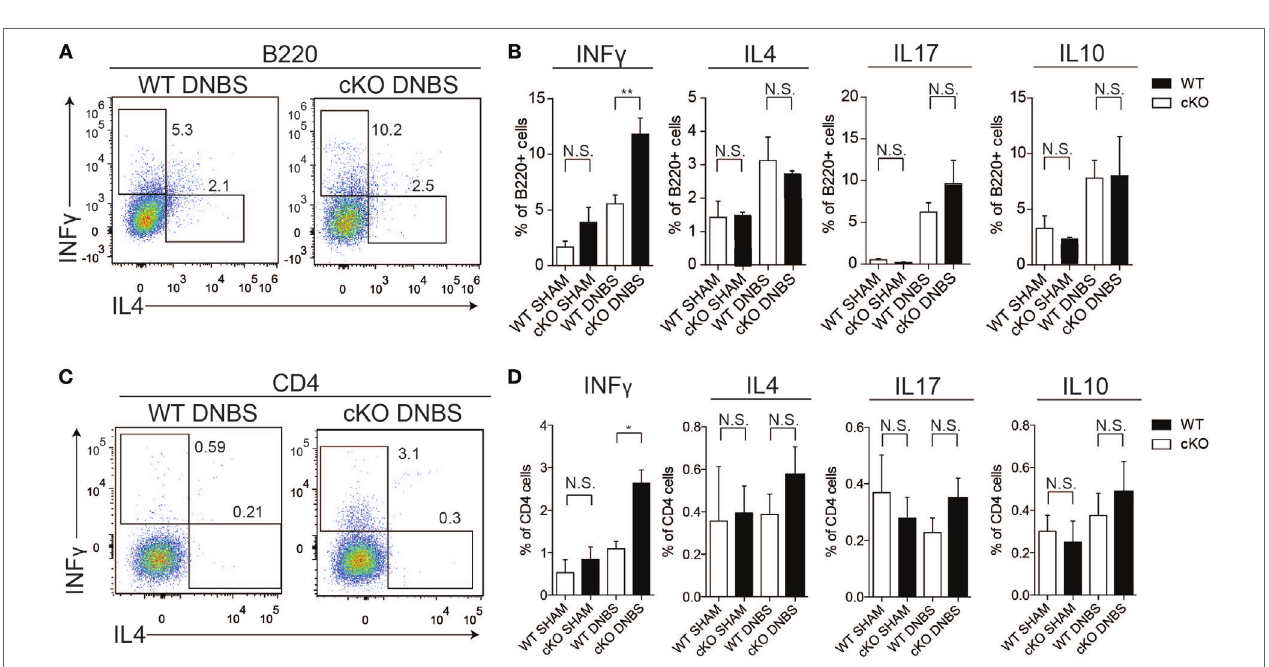
FigUre 6 | Increased IFN- γ production in lamina propria (LP) of the colon in gilz B cKO mice upon dinitrobenzene sulfonic acid (DNBS)-induced colitis. (a) Representative plots of flow cytometry analysis of IFN- γ and IL4 production by B220 + cells isolated from LP of the colon of wild-type (WT) and gilz B cKO mice upon DNBS-induced colitis. (B) Graphs representing IFN- γ , interleukin (IL)-4, IL-17, and IL-10 production by B220 + cells isolated from LP of the colon of WT and gilz B cKO mice following DNBS-induced colitis. (c) Representative plots of flow cytometry analysis of IFN- γ and IL4 production by CD4 + cells of the colon of WT and cKO mice upon DNBS-induced colitis. (D) Graphs representing the frequency of IFN- γ , IL-4, IL-17, and IL-10 production by CD4 + cells isolated from LP of the colon of WT and gilz B cKO mice following DNBS-induced colitis ( n = 10, 9) N.S., not significant, statistical analysis was performed using the unpaired Student’s t -test (* p < 0.05, ** p < 0.005).